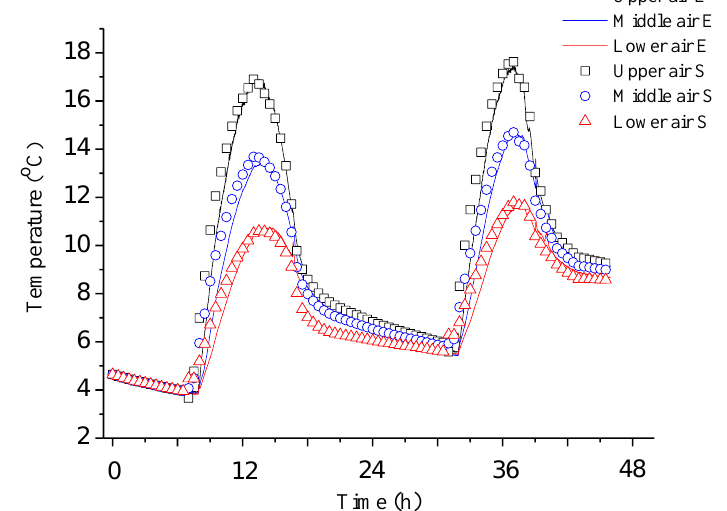
Figure 7. Comparison of measured and predicted temperatures of the indoor air at different height positions (E — experiment; S — simulation).